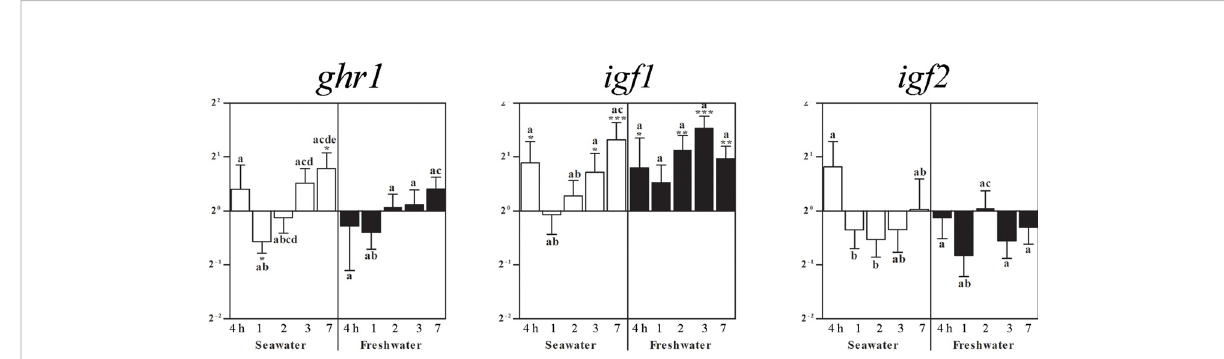
FIGURE 4 Effects of exposure to seawater and freshwater on pituitary ghr1 , igf1 , and igf2 gene expressions. Relative changes (log 2 , y-axis) of mRNA expression at 4 h, 1, 2, 3 and 7 days (x-axis) after exposure to seawater (white columns) and freshwater (black columns). Bars represent mean ratios between treated and control group ± SEM and asterisks show signi fi cant differences: * p < 0.05; ** p < 0.005; *** p < 0.0005. Bars within treatment groups that do not share any letters are signi fi cantly different from each other: p < 0.05, e.g., igf2 seawater expression between 4 h and 1 or 2 days are signi fi cantly different, but between 4 h and 3 or 7 days and between 1 or 2 days and 3 or 7 days are not signi fi cantly